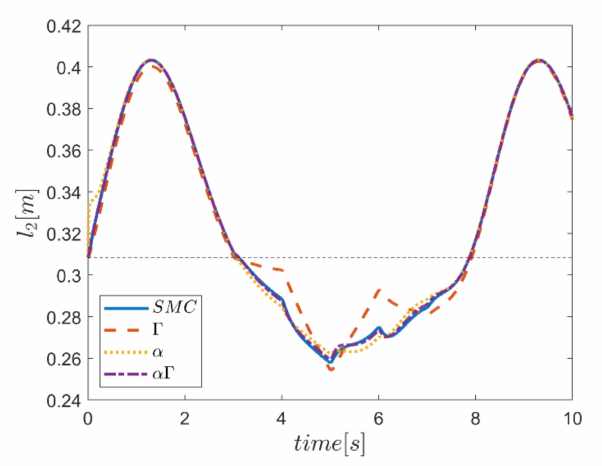
Figure 35. Comparison of the length of the second